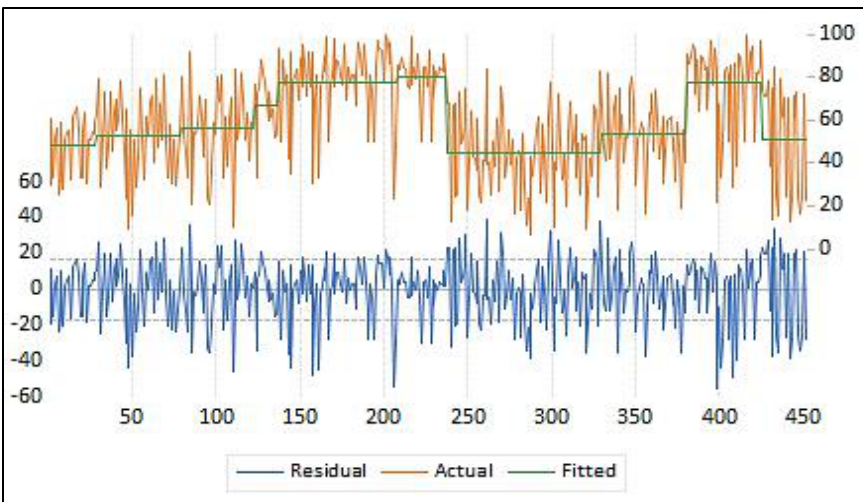
Figure 4. OLS regression estimation dummy variables for sectors